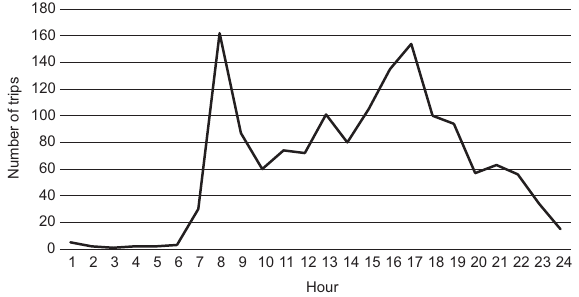
Fig. 10. Number of trips during 24 hours in the city of Pristina.